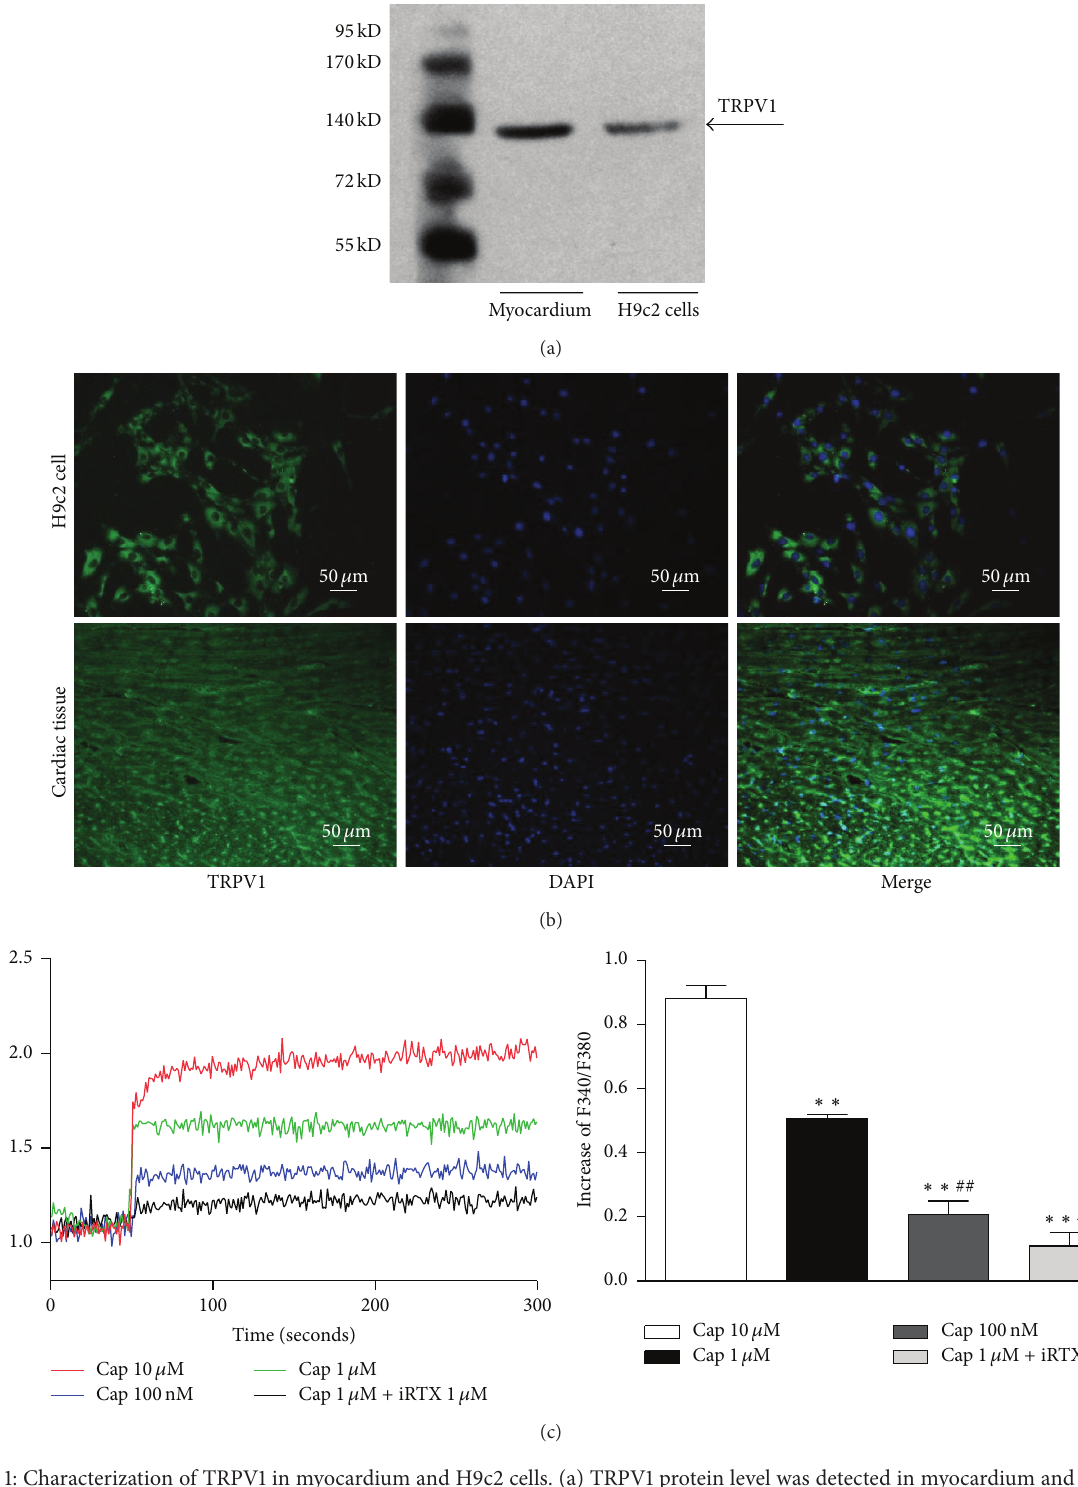
Figure 1: Characterization of TRPV1 in myocardium and H9c2 cells. (a) TRPV1 protein level was detected in myocardium and H9c2 cells. (b) TRPV1 localization in H9c2 cells and cardiac tissues of WT mice was shown with immunofluorescence. TRPV1 was stained in green and the nucleus was stained using DAPI (blue color). Images are representative of three separate experiments. The scale bar denotes 50 𝜇 m. (c) Fura-2-loaded H9c2 cells were stimulated by increasing the concentration of capsaicin (0.1–10 𝜇 mol/L) in the presence or absence of TRPV1 antagonist iRTX; values were expressed as the mean ± SEM from six separate experiments. Cap: capsaicin. ∗∗ 𝑃 < 0.01 versus Cap (10 𝜇 mol/L) and ## 𝑃 < 0.01 versus Cap (1 𝜇